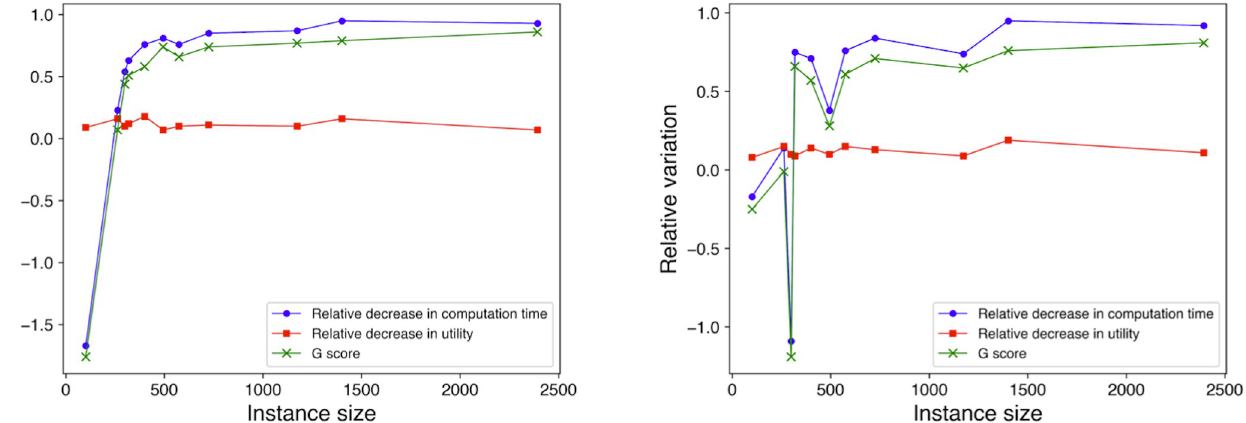
Fig 4. Performance of MH EA 4 OP vs. H EA 4 OP . Gain achieved by using MH EA 4 OP instead of H EA 4 OP vs. instance sizes. (Left) OP instances with Flat utility scores. (Right) OP instances with Random utility scores.